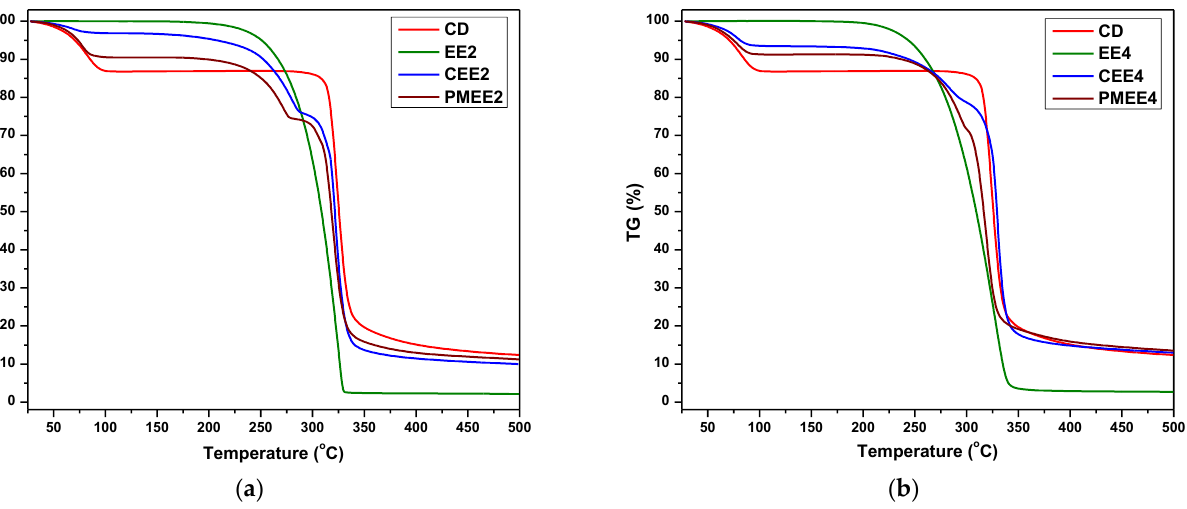
Figure 5. TGA curves of β -cyclodextrin, ethyl ester, inclusion complex, physical mixture: ( a ) ethyl 2-(2-((2-chlorophenyl)carbamoyl)phenoxy)acetate series; ( b ) ethyl 2-(2-((4-chlorophenyl) carbamoyl)phenoxy)acetate series.